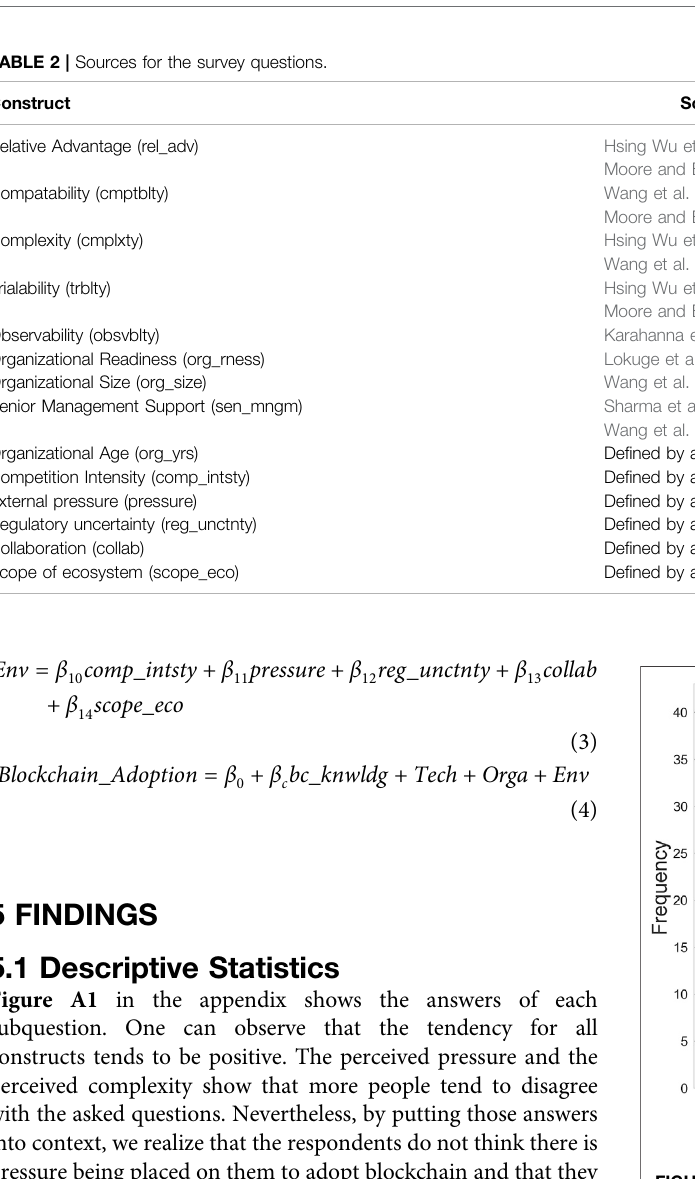
FIGURE 2 | Distribution of